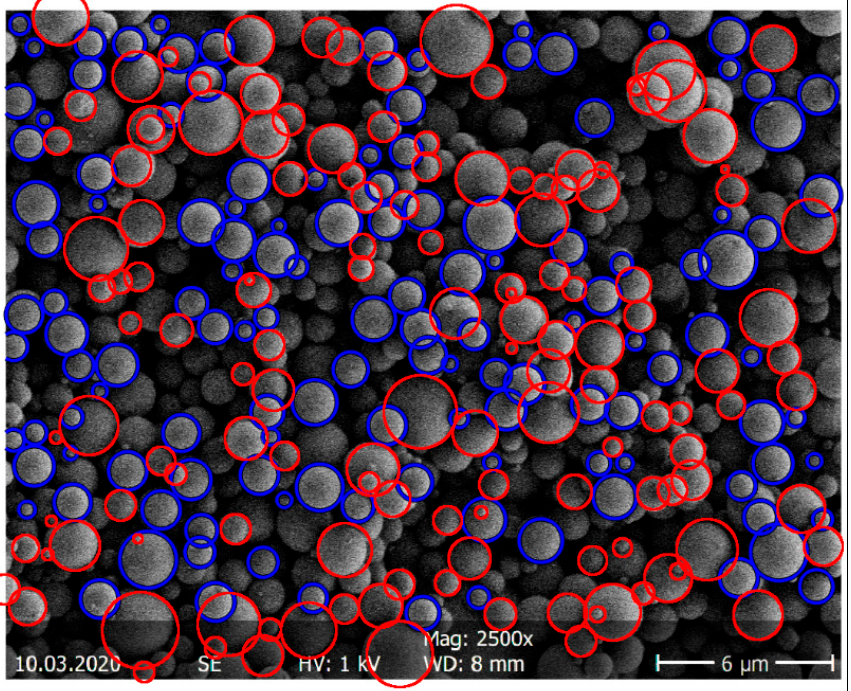
Figure 2. Example determination of the particle-size distribution of an ITR/Soluplus ® ASD via MATLAB (blue) and ImageJ